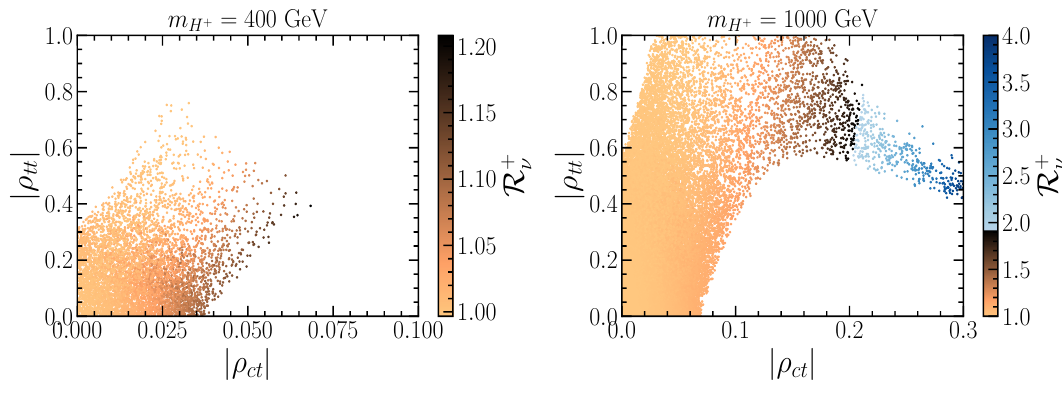
Figure 7 . Scatter plot in | ρ ct | – | ρ tt | , correlated with R +